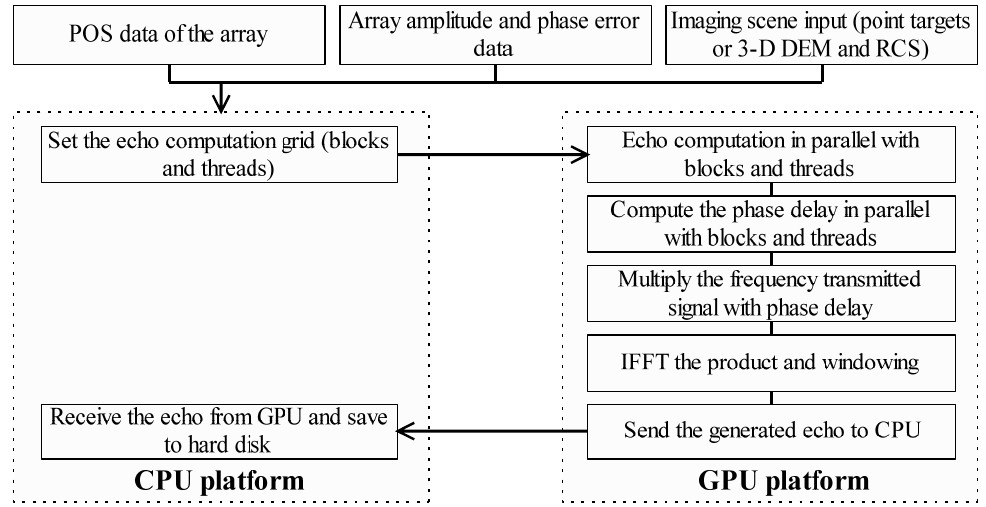
Figure 5. Heterogeneous parallel echo generation simulation with frequency domain correlation